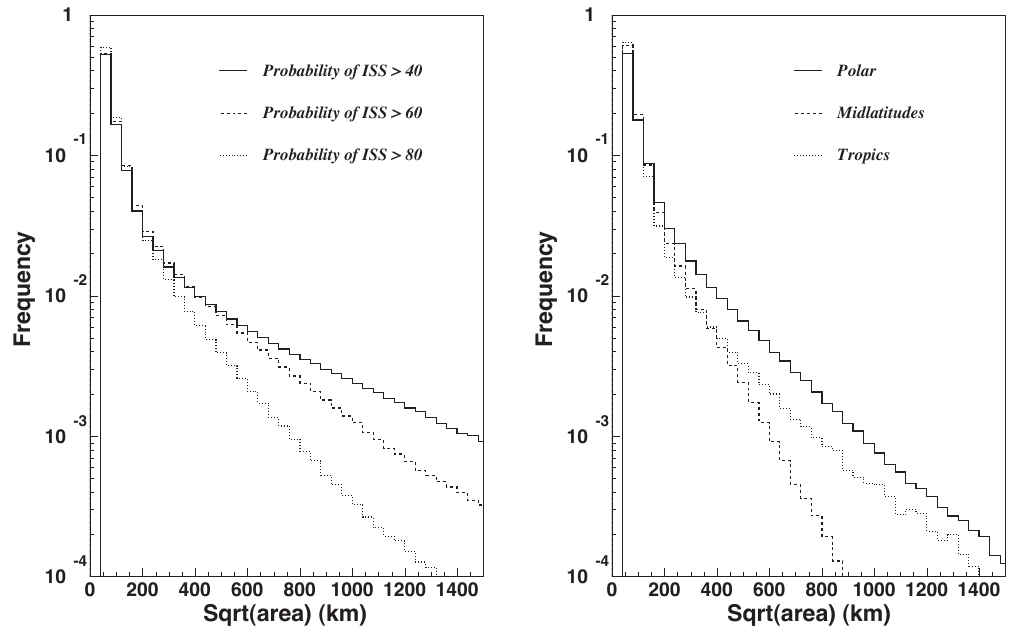
Fig. 8. Characteristic size of clusters of ice supersaturated areas from AIRS. Left: S > 40%, S > 60% or S > 80%, all regions combined. Right: S > 80% for polar regions (latitude higher than 70 ◦ N or S), midlatitudes (40–60 ◦ N and S) and tropics (20 ◦ N–20 ◦